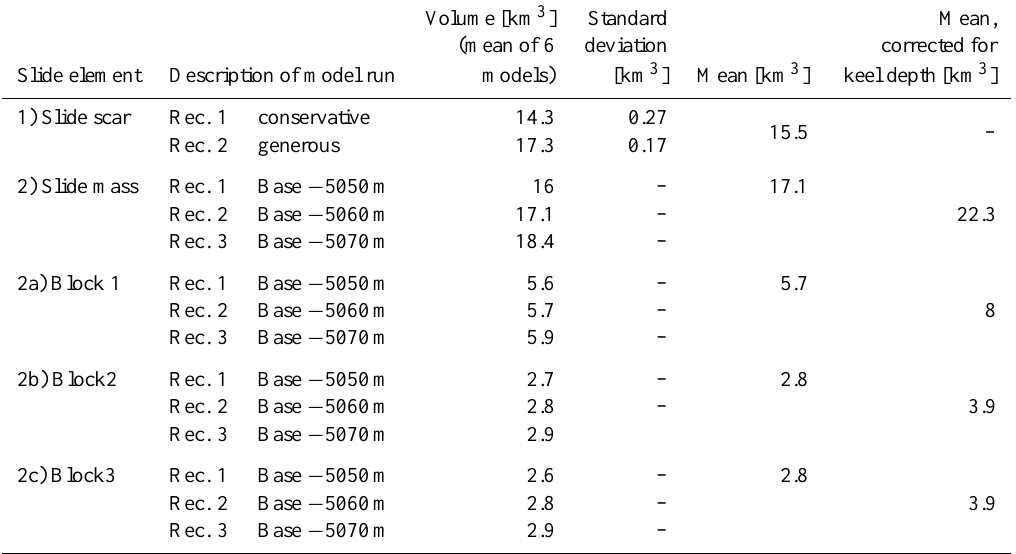
Table 3. Calculated volumes of the slide scar as well as the slide mass and it’s major components. The volumes of the slide scar represent a mean of six model runs with the same elevation input values but different interpolation parameters. As the water depth of the trench floor ranges between 5050 and 5070m, we conducted three calculations and propose a